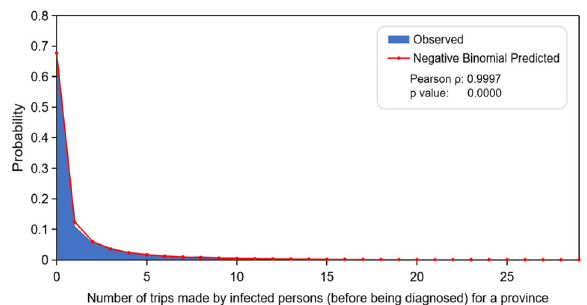
Fig. 2 Predicted number of trips made by the infected. Negative binomial model predicted number of trips made by infected people and its actual